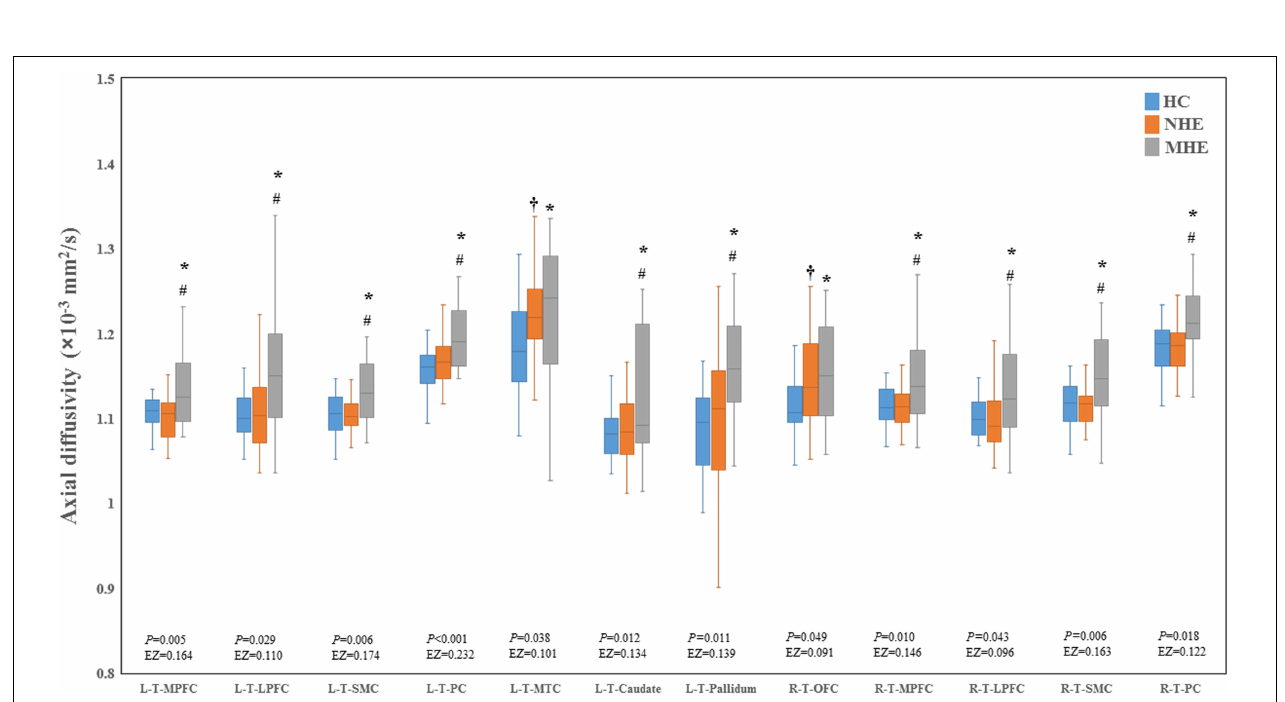
FIGURE 5 | Between-group differences in axial diffusivity. The false discovery rate (FDR)-corrected P values and the effect size (EZ) are shown. The symbols *, † , and # indicate significant differences in MHE vs. HC, NHE vs. HC, and MHE vs. NHE, respectively. MHE, minimal hepatic encephalopathy; NHE, patients without MHE; HC, healthy control; LPFC, lateral prefrontal cortex; MPFC, medial prefrontal cortex; MTC, medial temporal cortex; OFC, orbitofrontal cortex; PC, parietal cortex; SMC, sensorimotor cortex; T, thalamus; L, left; R, right.